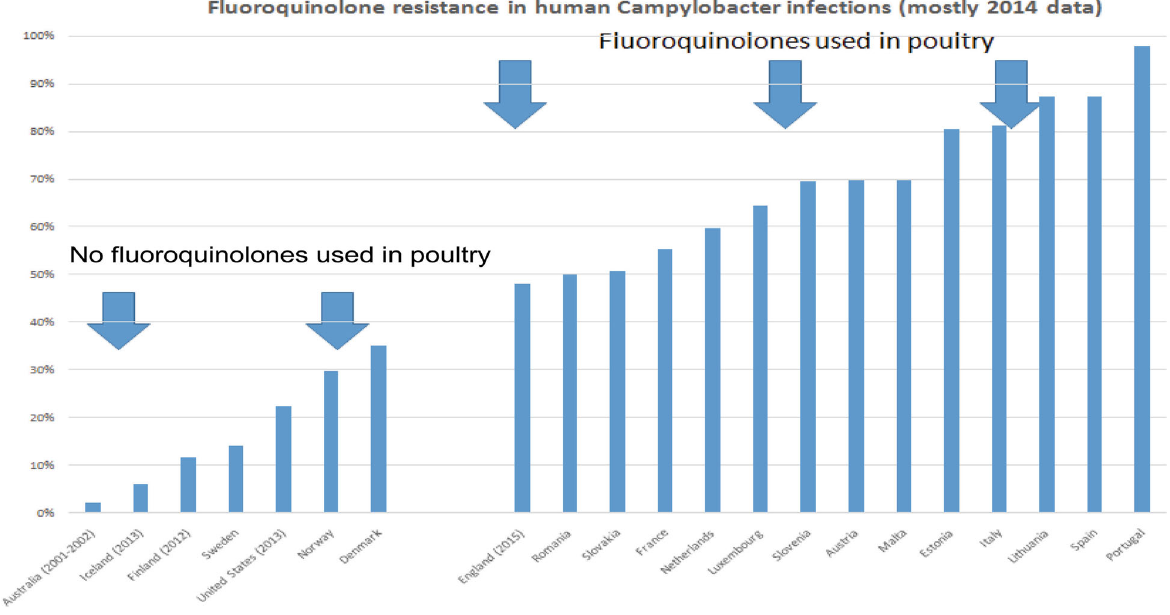
Fig. 8 Fluoroquinolone resistance in human Campylobacter jejuni infections (ECDC 2014